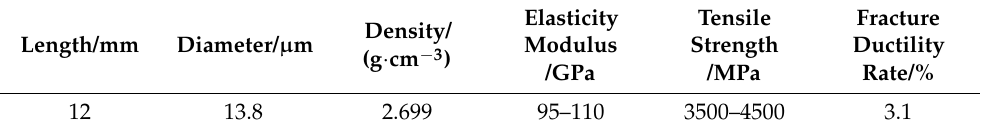
Table 2. Physical and mechanical indices of basalt fiber.